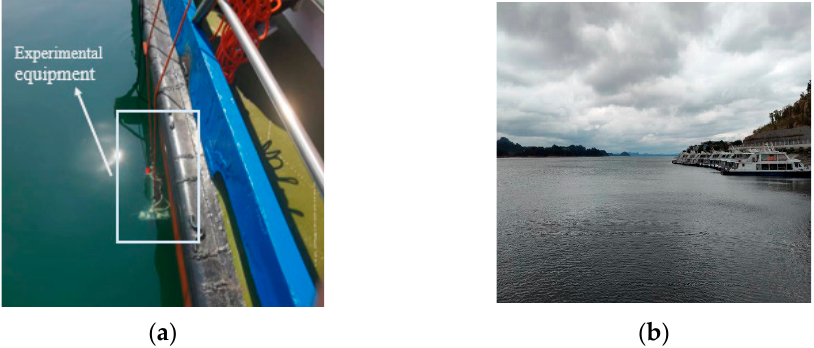
Figure 15. Qiandao Lake experimental environment. ( a ) Placement of experimental vessel and equipment. ( b ) There are several boats docked at the lake, and there are steps on the side of the boats.